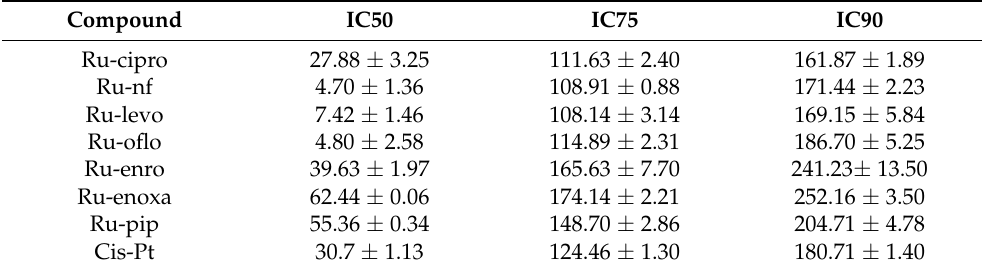
Table 2. Values ( µ M) of IC50, IC75, and IC90, for Ru(III) complexes and CisPt-mediated